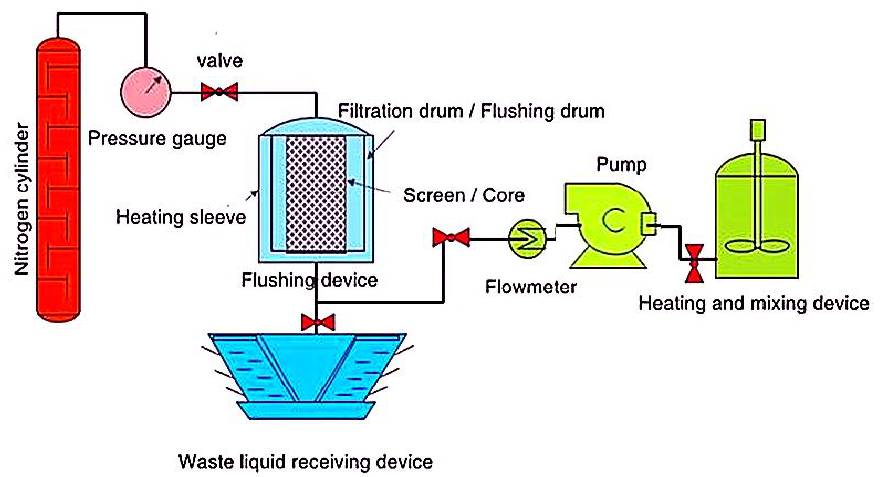
Figure 2. Design flow chart of flushing device.